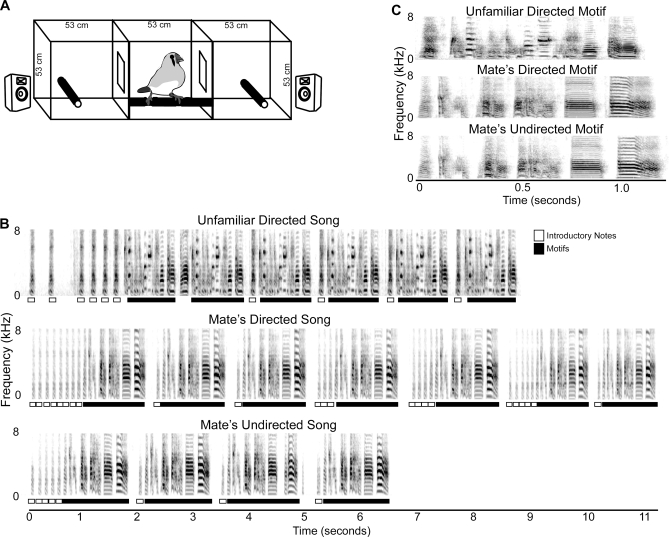
Diagram of Behavioral Assay and Sonograms Illustrating Song Differences between and within Males(A) Diagram of the two-choice behavior assay. Tests began when females were in the center chamber containing food, water, and a perch. Stimuli were played alternately from speakers at each end of the cage, and females moved freely into the side chambers. Thick lines in the side and center chambers indicate perches.(B) Examples of a directed song bout from an unfamiliar male and directed and undirected song bouts from a mate. Introductory notes are indicated with open lines, and motifs are indicated with black lines. In these examples, there are more motifs in both of the directed songs (unfamiliar and mate's song) than the undirected song.(C) Sonograms of single motifs from each of the song examples. These examples highlight the much greater differences between the songs of different birds (e.g., unfamiliar male versus mate) than between songs produced in the two contexts by the same bird (mate's directed versus mate's undirected).